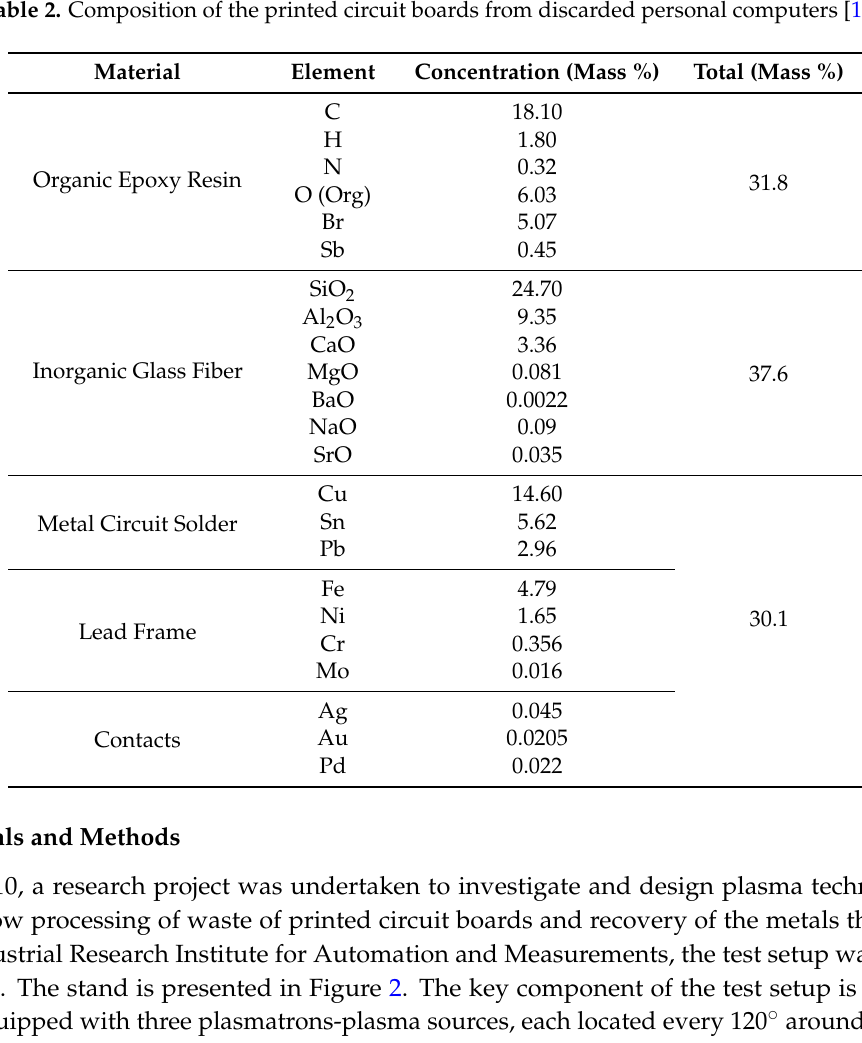
Table 2. Composition of the printed circuit boards from discarded personal computers [15].